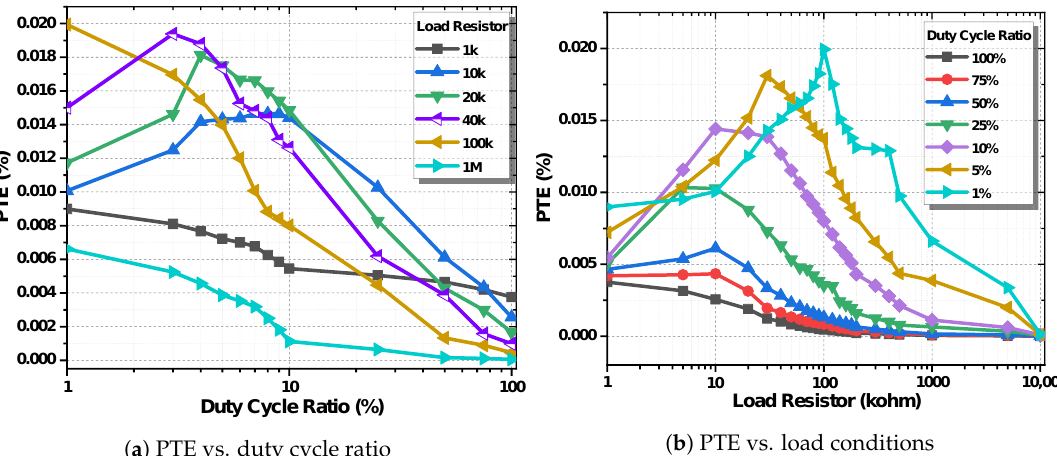
Figure 10. ( a ) PTE over the duty cycle ratio for various load resistances. ( b ) PTE over the load resistance for various duty cycle